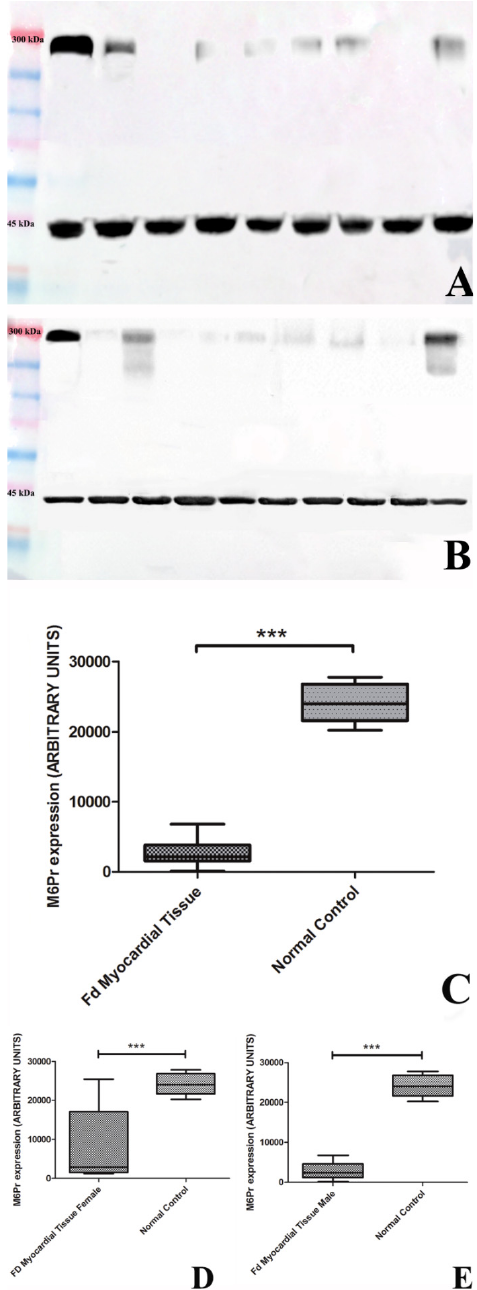
Figure 3. Panel ( A , B ): Western blot analysis of all 17 patients of M6Pr, molecular weight 275 Kd. Panel ( A ): Lane1 = Markers; Lane 2 = Control; Lane 3 = patient 1; Lane 4 = patient 2; Lane 5 = patient 3; Lane 6 = patient 4; Lane 7 = patient 5; Lane 8 = patient 6; Lane 9 = patient 7; Lane 10 = patient 8. Panel ( B ): Lane 1 = Markers; Lane 2 = Control; Lane 3 = patient 9; Lane 4 = patient 10; Lane 5 = patient 11; Lane 6 = patient 12; Lane 7 = patient 13; Lane 8 = patient 14; Lane 9 = patient 15; Lane 10 = patient 16; Lane 11 = patient 17. Panel ( C – E ): Graphs document western blot of M6Pr, in all 17 patients with FDCM showing 5.4-fold lower of M6Pr values in patients versus normal heart (4289 ± 6595 vs. 23,581 ± 4074, p = 0.0996) ( p < 0.001), ( C ), 9-fold lower in male, p = 0.009, ( p < 0.001), ( D ) and 3-fold lower in female p = 0.5799, ( p < 0.001), ( E ). Alpha sarcomeric actin(43 kDa) was used as a loading control. *** = p <